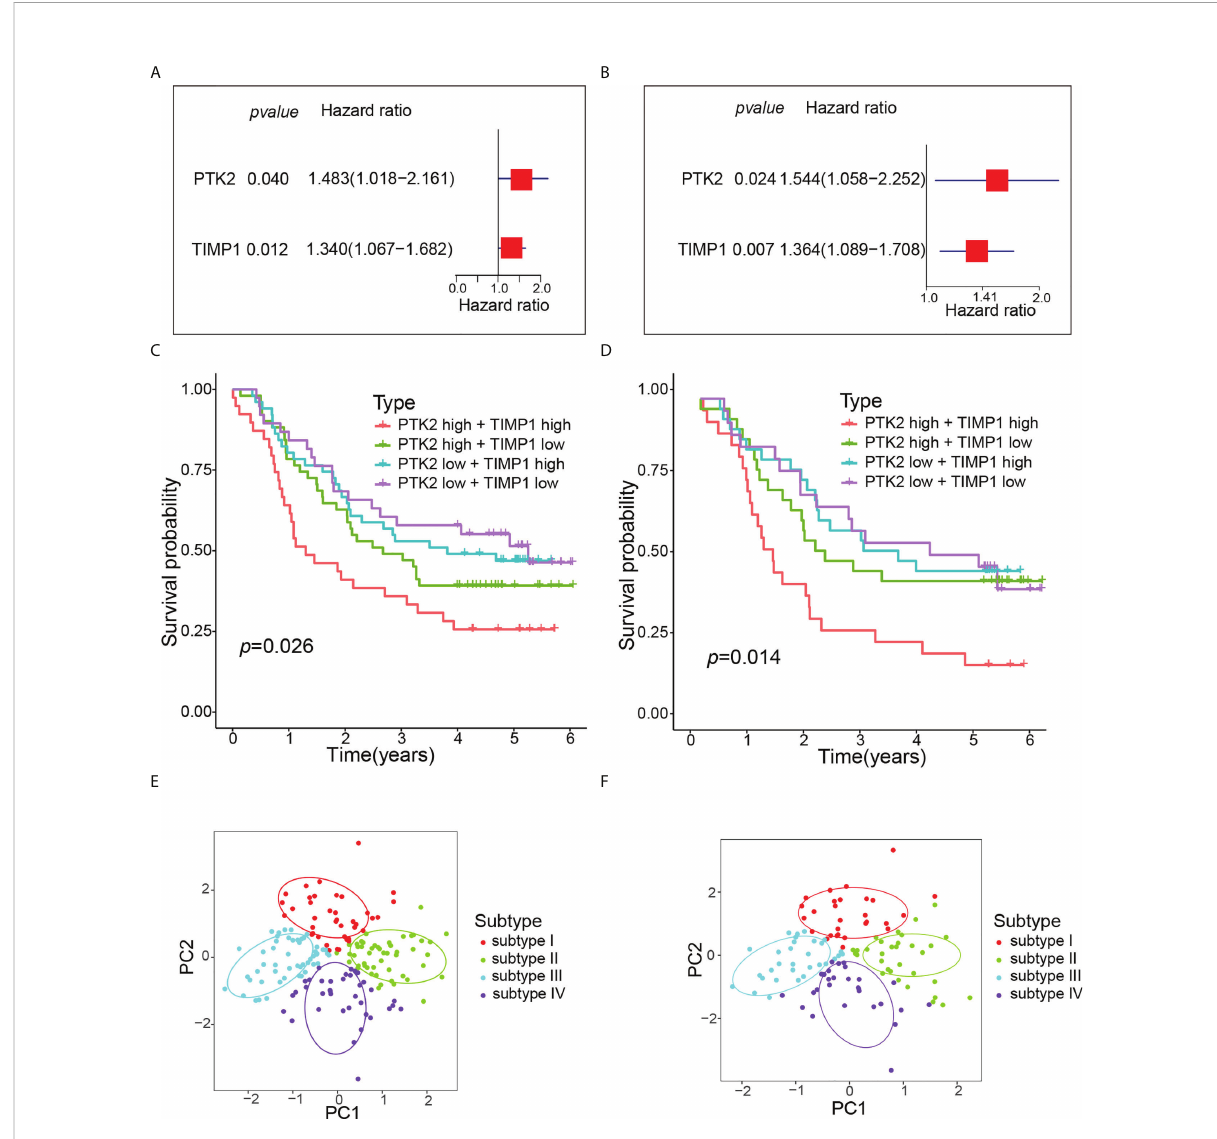
FIGURE 5 Molecular typing of ESCC patients. (A) Univariate Cox regression analysis of OS according to angiogenesis genes expression in GSE53625. (B) Multivariate Cox regression analysis of OS according to angiogenesis genes expression in GSE53625. (C) Kaplan-Meier curve of OS for four subtypes in GSE53625. (D) Kaplan-Meier curve of OS for four subtypes in GSE53624. (E) PCA revealed that all ESCC patients were well divided into four subtypes in GSE53625. (F) PCA revealed that all ESCC patients were also well divided into four subtypes in